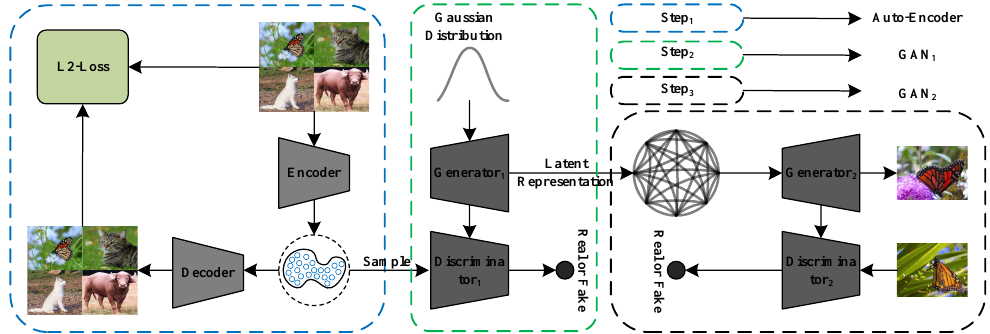
Figure 1. The proposed workflow of Express Construction, all components are parameterized by neural networks. An auto-encoder is trained to map the data manifold into the latent manifold, as shown with the blue dashed box. Then, an adversarial game between a discriminator and a generator with a small scale is used to produce a generated latent representation from random noise, as shown in the green dashed box. Finally, a GAN model with a large scale is trained to construct a transportation map from the result of the previous step to the data distribution, as the black dashed box